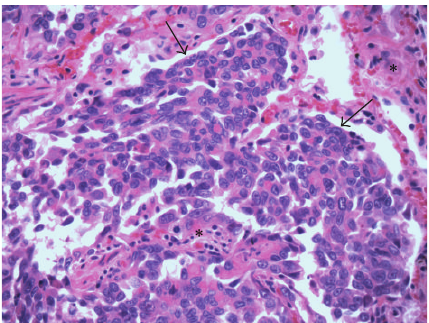
Figure5:Lung.Alveoliareexpandedbysheetsandnestsofneoplas- tic polygonal cells as observed in the thyroid gland (arrows). Multi- focaltocoalescingareasofnecrosis(asterisk)arepresentthroughout this neoplastic cell population (400x). H&E